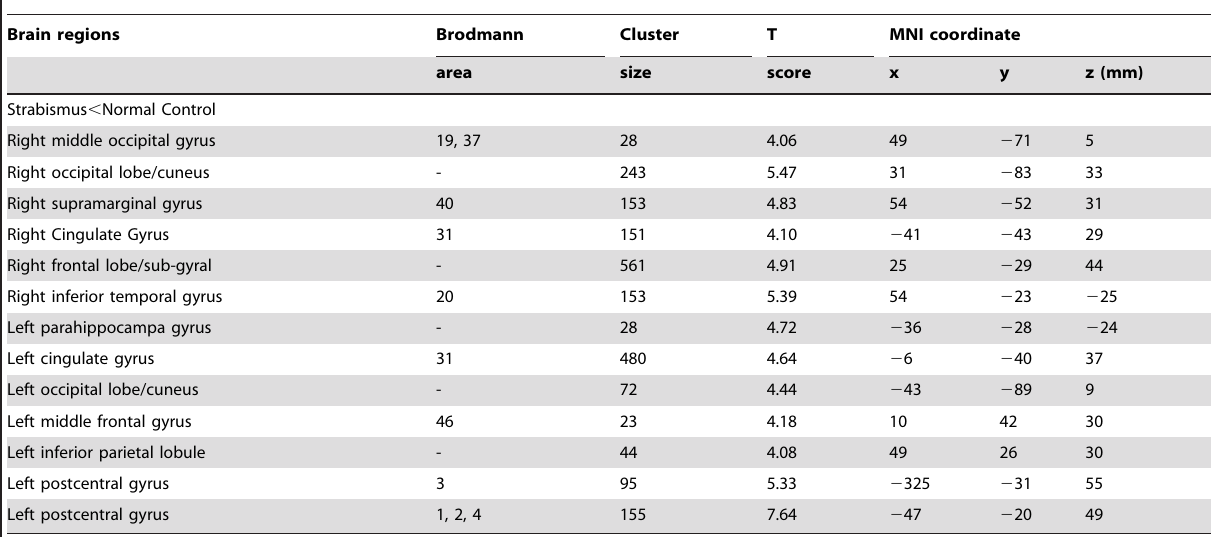
Table 2. Changes of white matter volumes in adult strabismus.